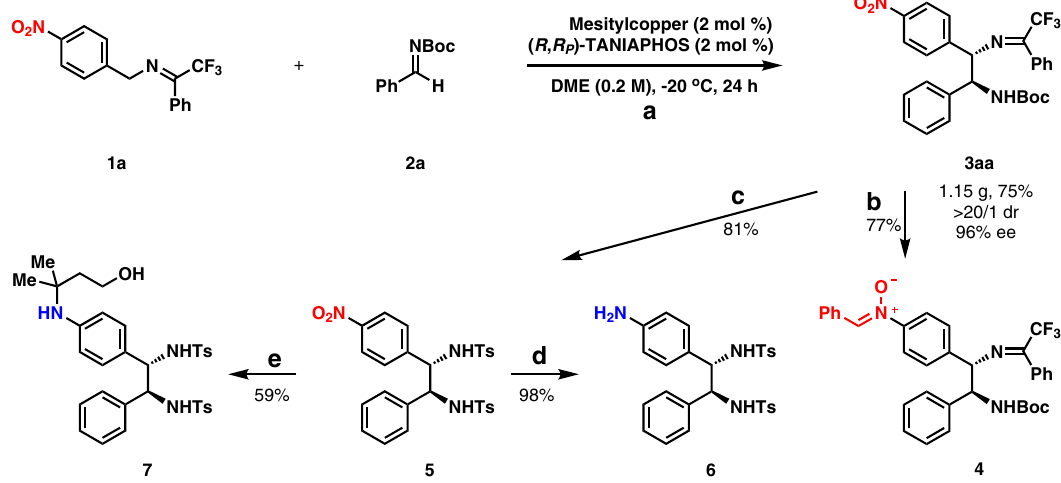
Fig. 4 Gram-scale reaction and transformations of the nitro group. a Gram-scale reaction. b Transformation of the nitro group to the nitrone group. Zn (6.0 equiv), HOAc (12.0 equiv), EtOH, 0 °C to RT. c Removal of the ketimine moiety and protection of the newly generated free amine moiety. (1) 12 M HCl, MeOH, RT; (2) TsCl, Et 3 N, DMAP, DCM, RT. d Reduction of the nitro group to the amine group. Pd/C, H 2 (1 atm), MeOH, RT. e Radical hydroamination. (1) 3-methylbut-3-en-1-ol (3.0 equiv), Fe(acac) 3 (30 mol %), PhSiH 3 , EtOH, 60 °C; (2) Zn, HCl, 60